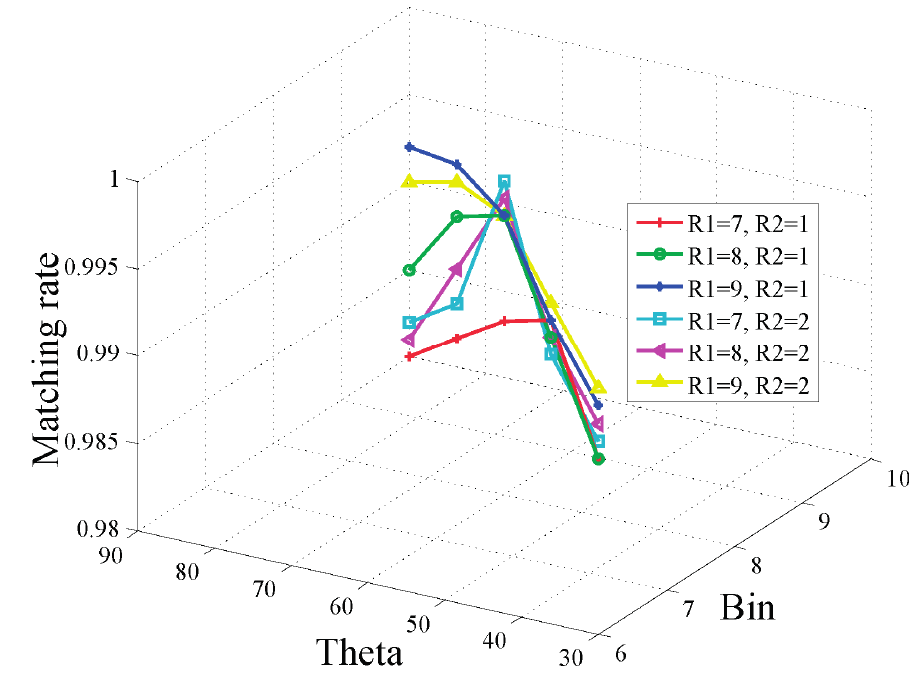
Figure 3. Matching rate.